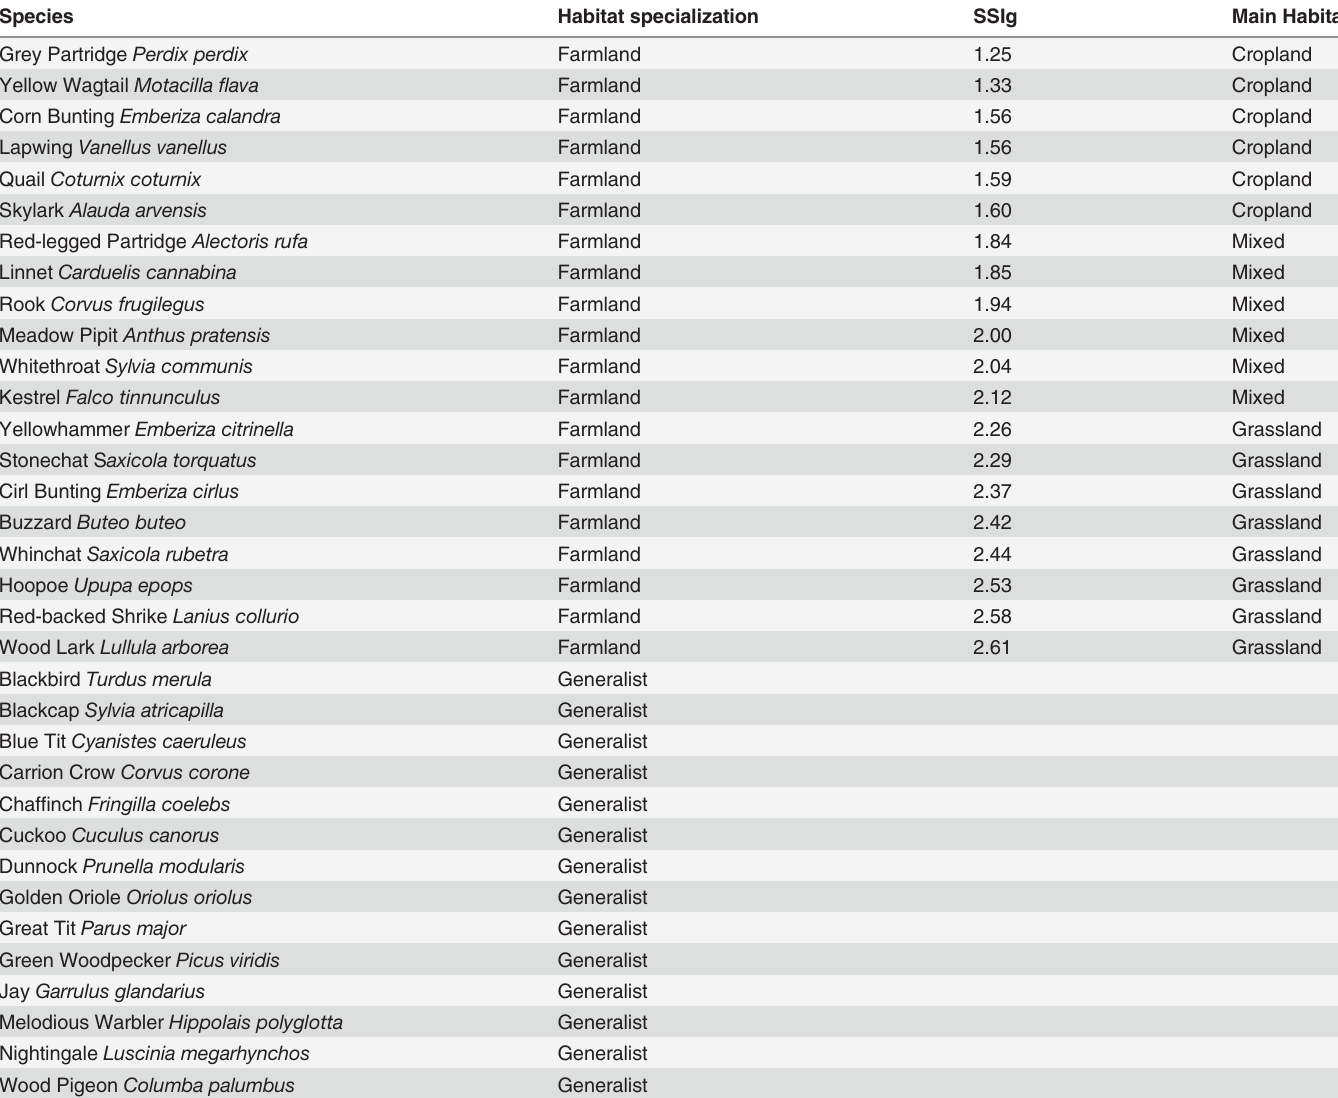
Table 1. List of the species comprising the bird community examined in this study and their habitat